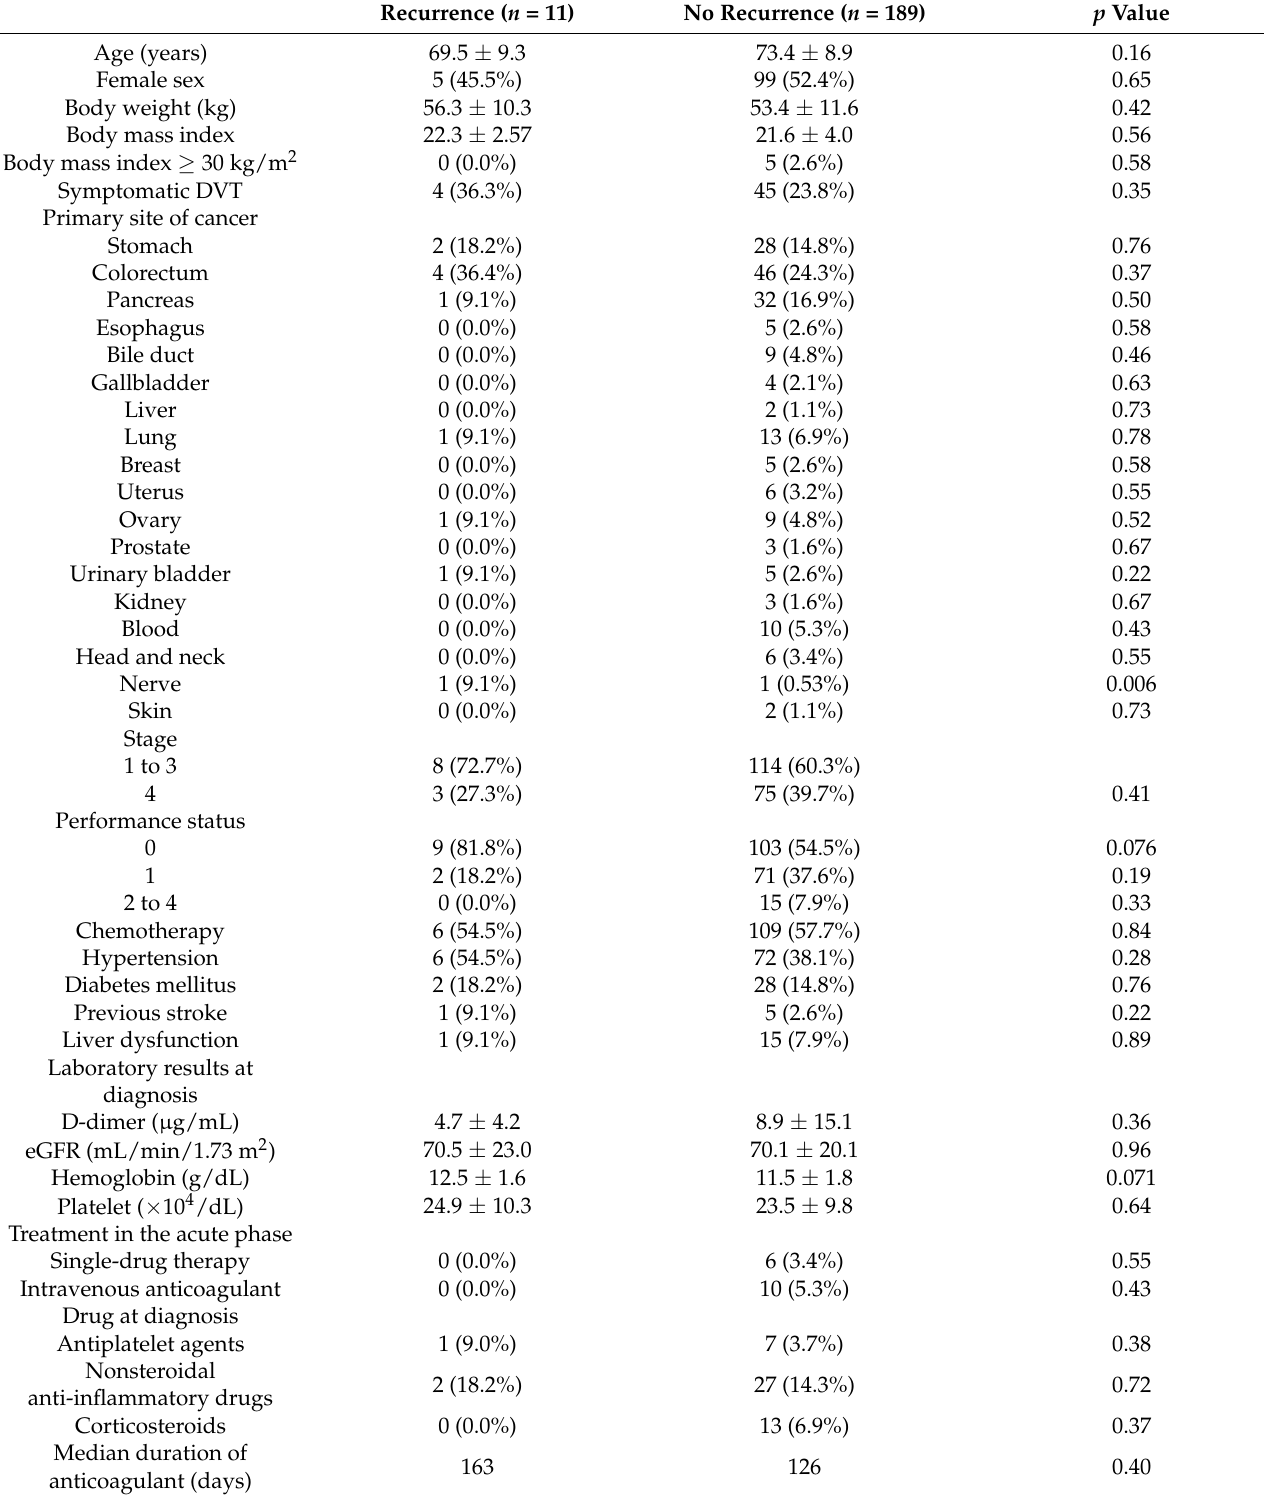
Table 3. Comparison between patients with and without